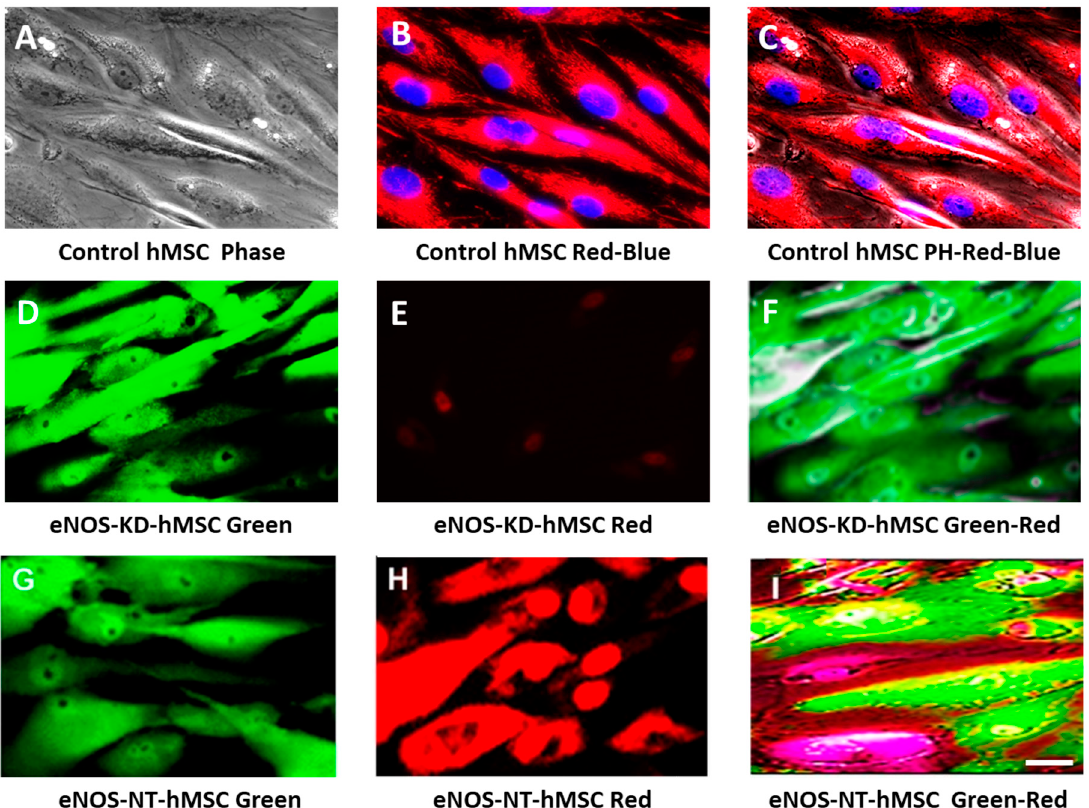
Figure 2. Live-cell real-time fluorescence images showing the effect of eNOS KD on mitochondrial biogenesis and/or function in hMSC: ( A – C ) control hMSCs in phase (PH), red-blue, and PH-red-blue overlay; ( D – F ) eNOS-KD-hMSCs in green, red, and green-red overlay; and ( G – I ) eNOS-NT-hMSCs in green, red, and green-red overlay. Scale bar 10 µm. Frames D–F are live-cell real-time fluorescence images of eNOS-KD-hMSCs in green (GFP), red (RFP), and green (GFP)-red (RFP) overlay. In frame D, the expression of green fluorescence protein in the targeting vector renders the cells green. In frame E, only a few